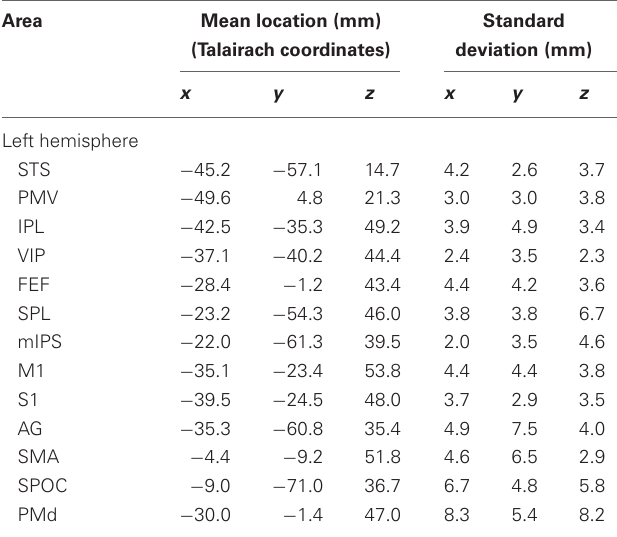
Table 2 | Mean location and standard variation of the regions across all 10 subjects for the left hemisphere.